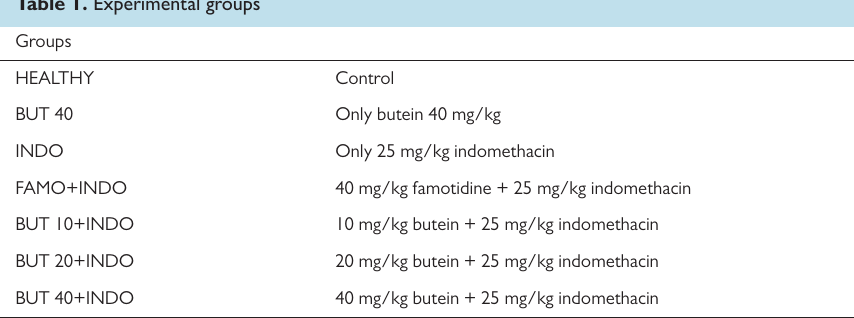
Table 1. Experimental